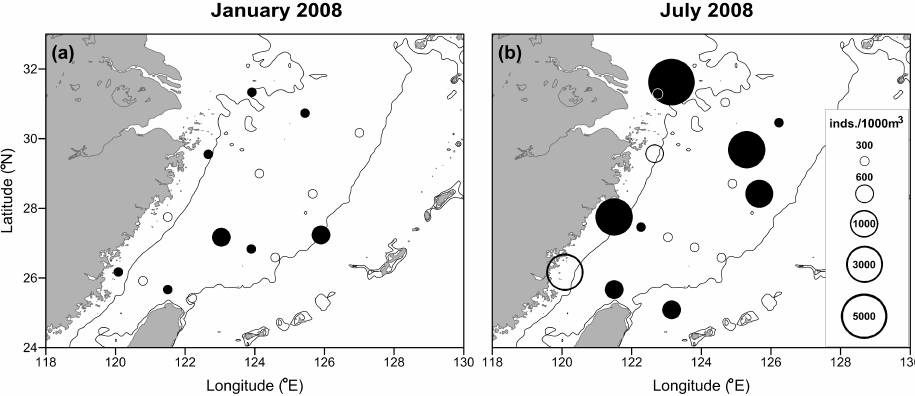
Fig. 5. CPUEs (ind./1000m 3 ) of larval fish in the northeasterly monsoon season (a) and the southwesterly monsoon season (b) ( open circles, daytime sampling; solid circles, nighttime